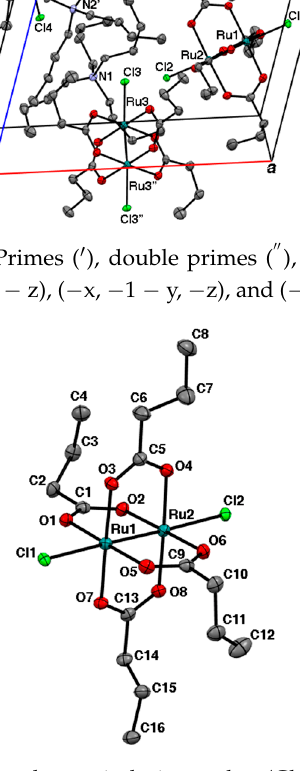
Figure 2. Structure of an anionic dinuclear unit designated as (Cl1–Ru1–Ru2–Cl2). Hydrogen atoms were omitted for clarity. The thermal ellipsoids are shown at the 50% probability level.